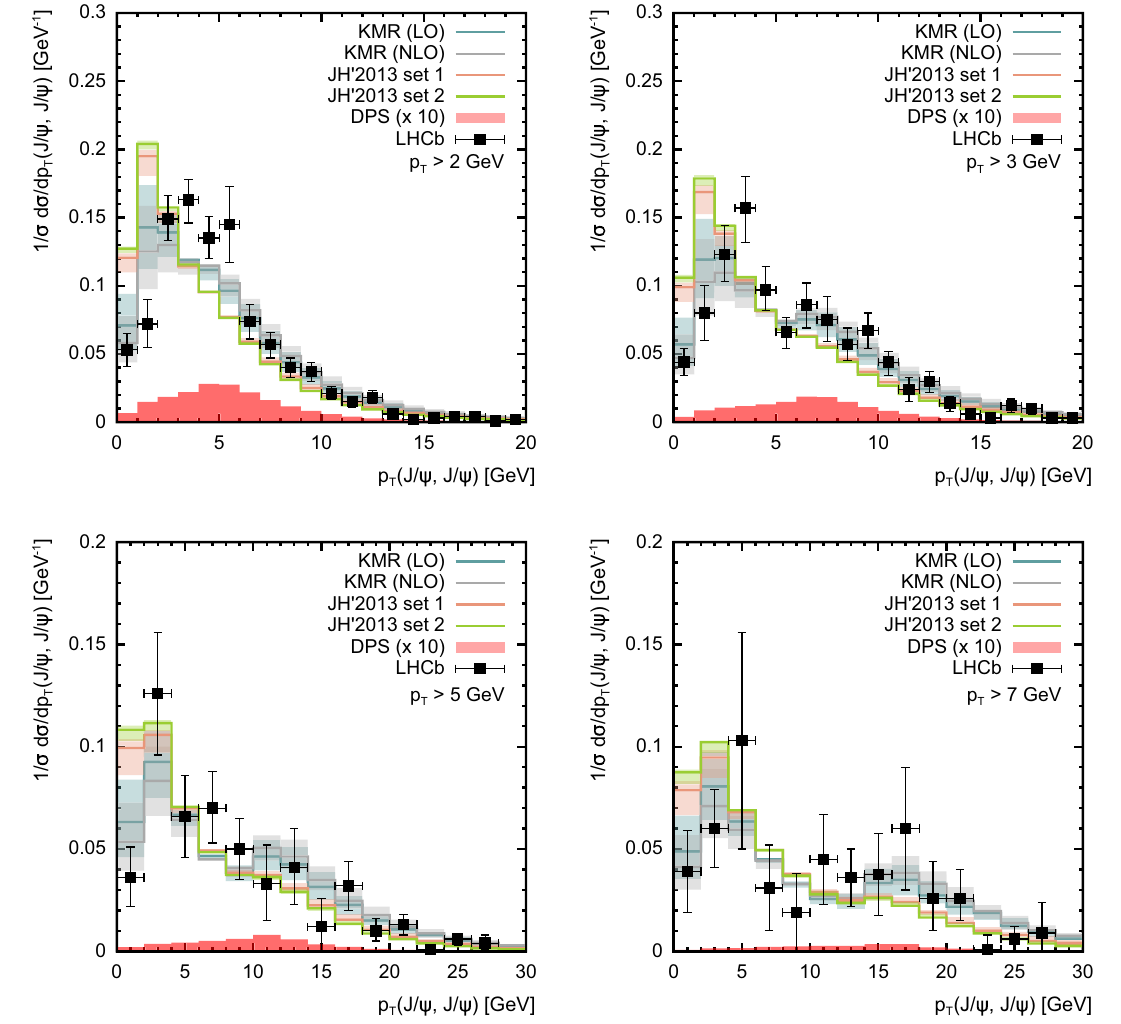
√ s = 8 TeV as a function of the transverse momentum